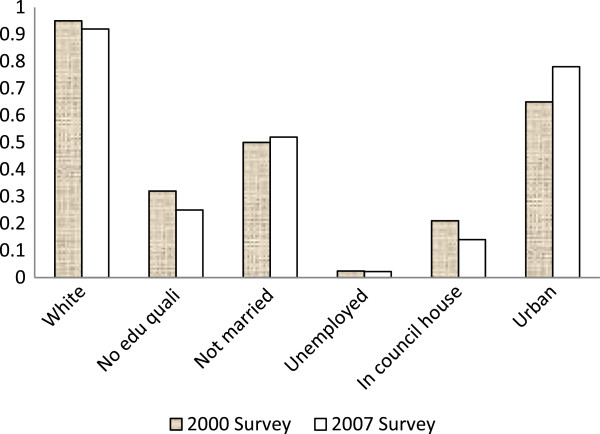
Distribution of women in percentage by demographics in the two surveys.